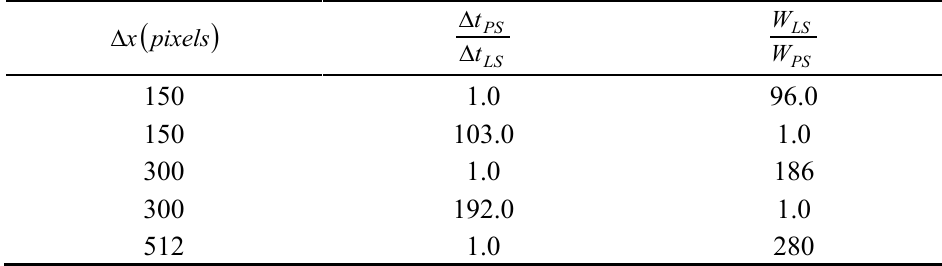
Table 1. Comparison of the relative signal level between the point- and line-scan ( W W ), respectively, when scanning a solution of 100 μM Uranine. The average power per LS pixel for line-scan was 0.72 mW and the average power per pixel measured at the peak of the PSF for the point-scan was 2.37 mW. The line-scan was executed using the lowest line dwell time allowed by the frame rate of the EMCCD (Δ t 150-pixel lines and 33 ms for 512-pixel